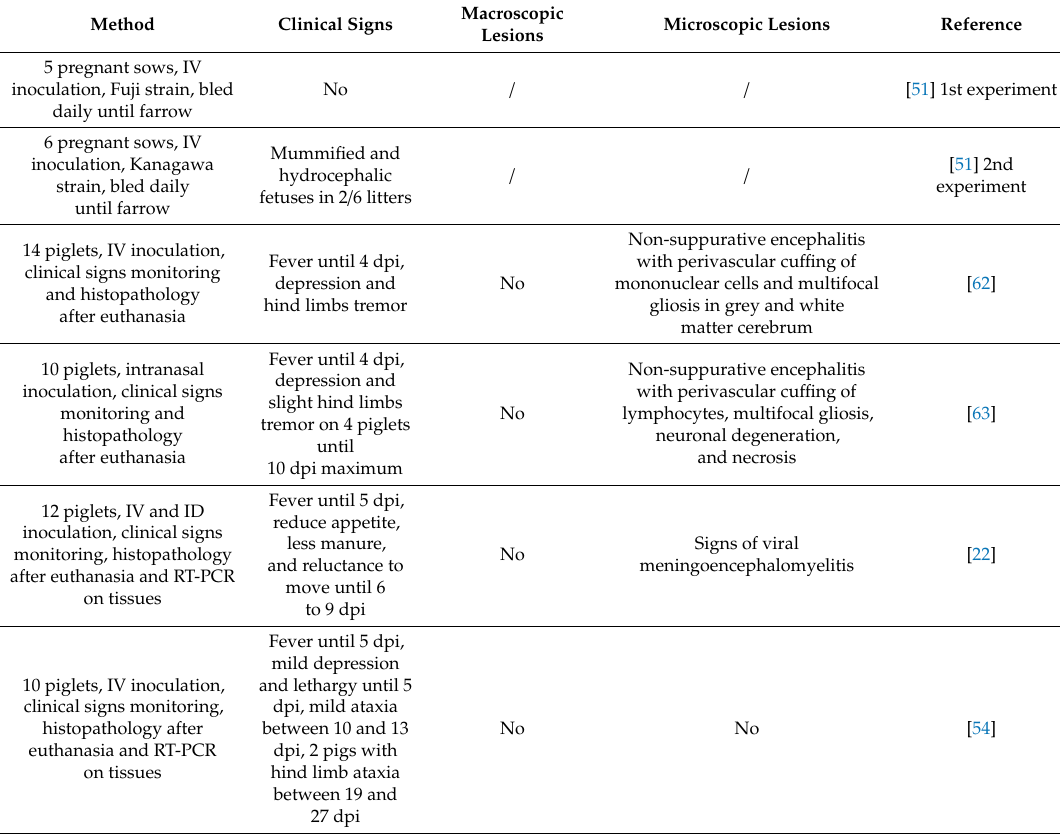
Table 2. Sow reproductive disorders after experimental JEV infection and clinical signs and lesions after experimental JEV infection of